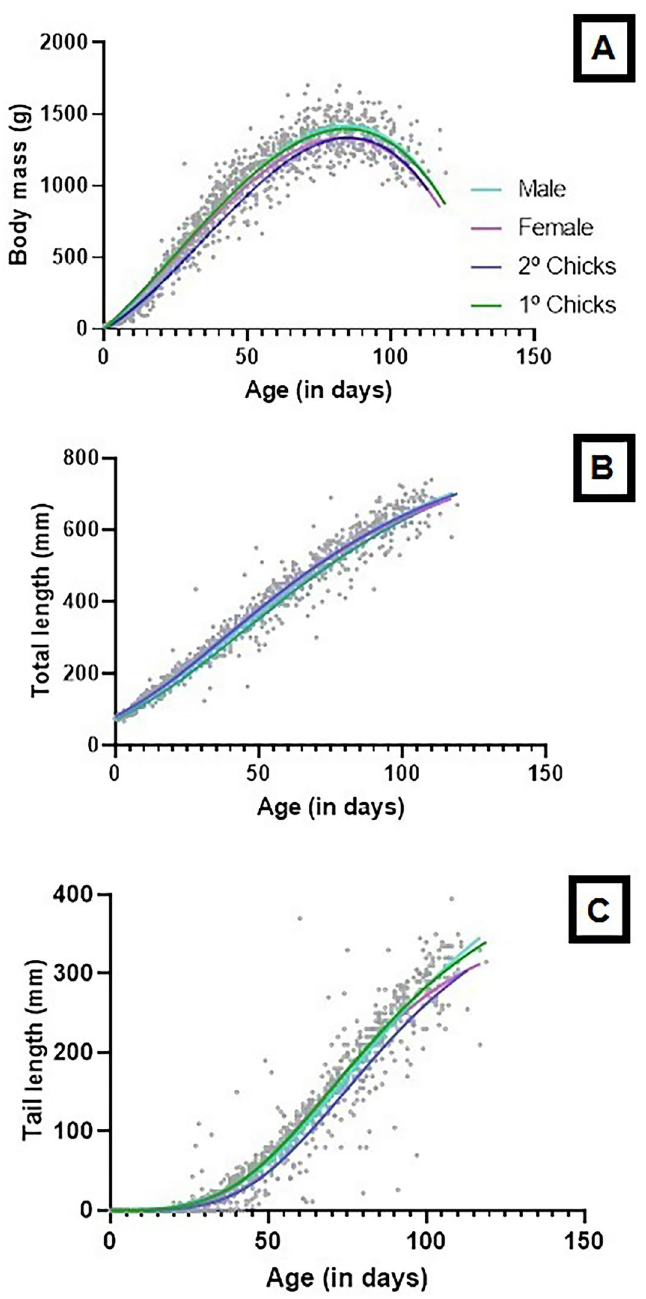
Figures were produced using GraphPad Prism v.